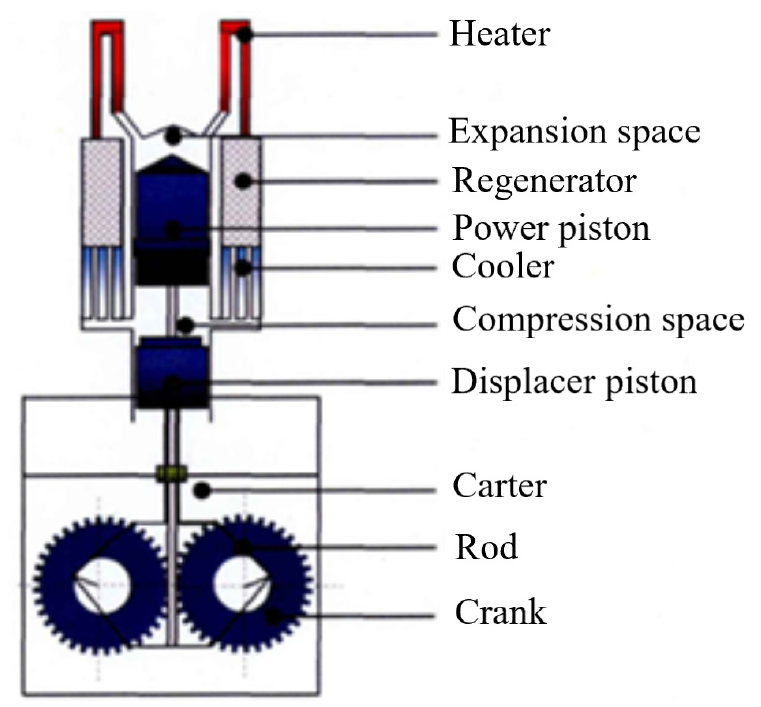
Figure 6. Schematic of GPU-3 engine.